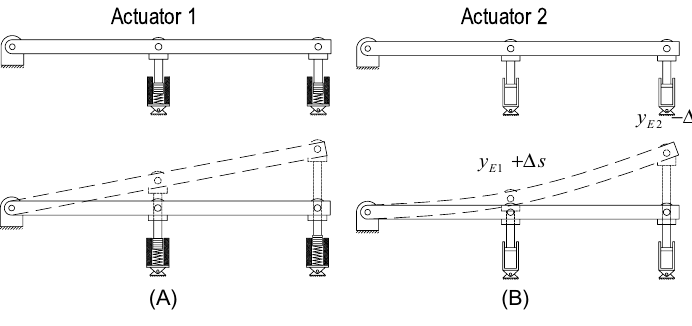
Fig. 8. Comparison between (a) Electrodynamic and (b) Hydraulic